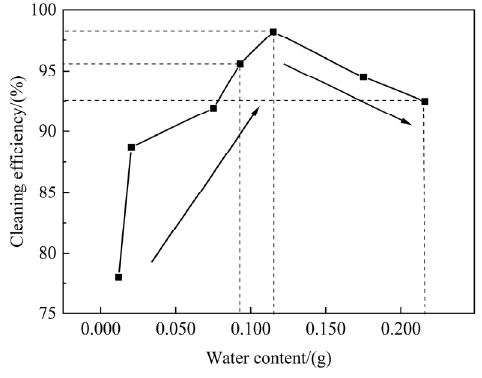
Figure 15. Relationship between cleaning e ffi ciency and water content.